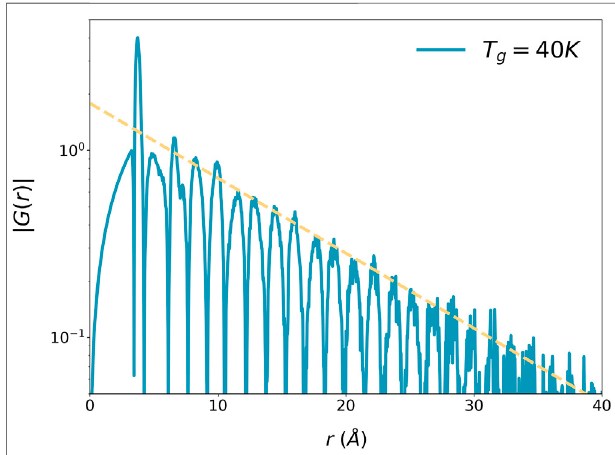
FIGURE 2 | The absolute values of the reduced PDF, | G ( r )| , of liquid Argon at T g = 40 K. The dashed line shows the exponential decay by Eq. 1 .